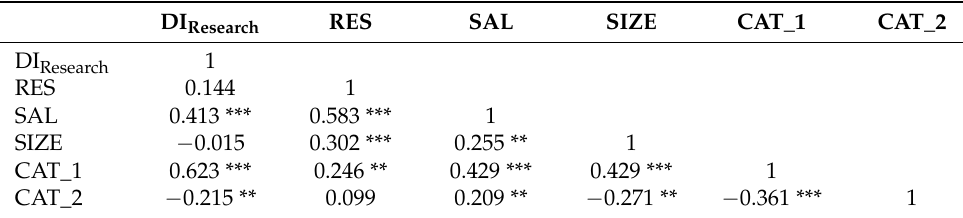
Table 6. Correlation matrix for research